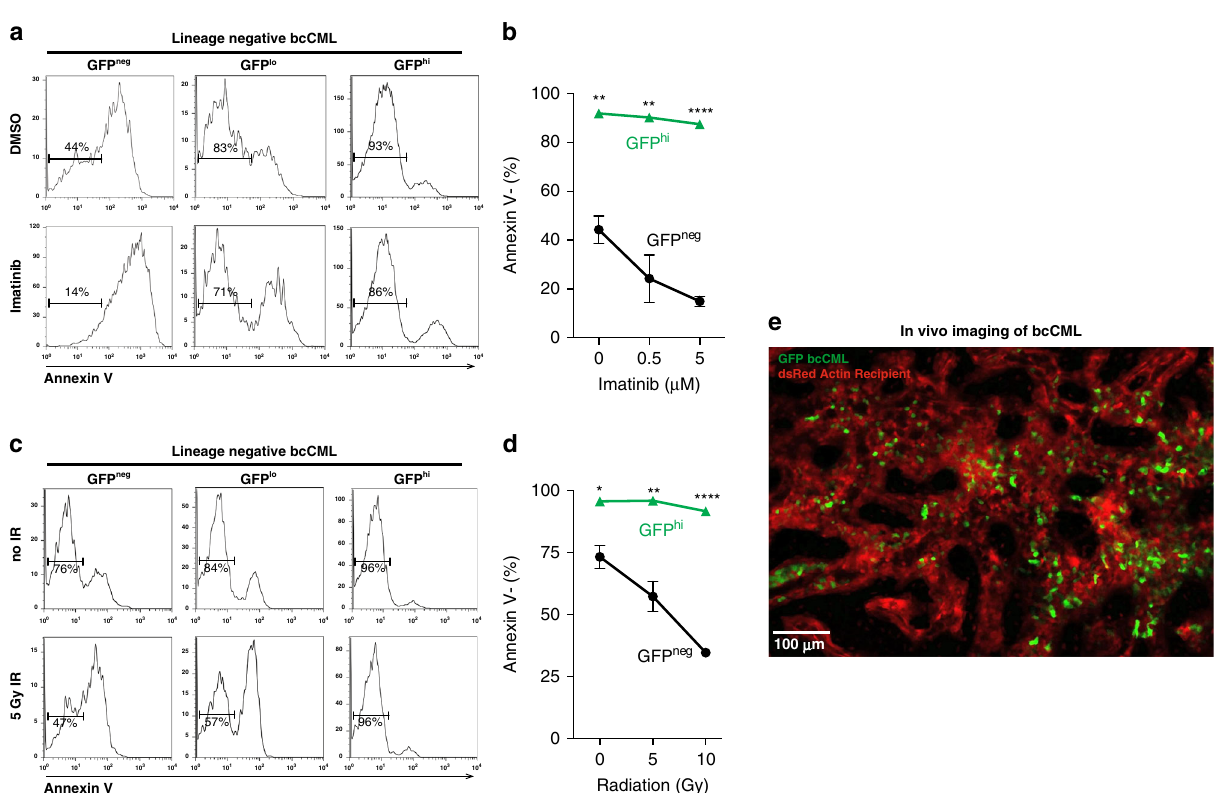
Fig. 2 Msi2 marks bcCML cells that are highly therapy resistant. a , b Msi2-expressing (GFP hi ) cells are highly resistant to imatinib-induced cell